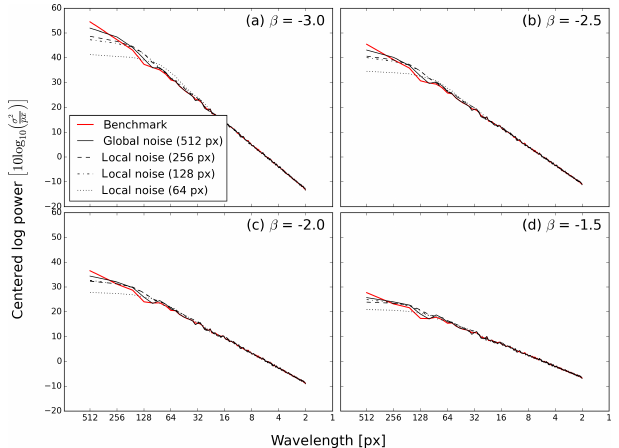
Figure 6. The radially averaged 1-D centred power spectra of syn- thetic realisations with spectral slope (a) β =− 3.0, (b) β =− 2.5, (c) β =− 2.0 and (d) β =− 1.5 (in red). In black are the correspond- ing average spectra of 20 non-parametric realisations for decreasing window sizes. The same experiment was realised with real precipi- tation fields (see Fig.